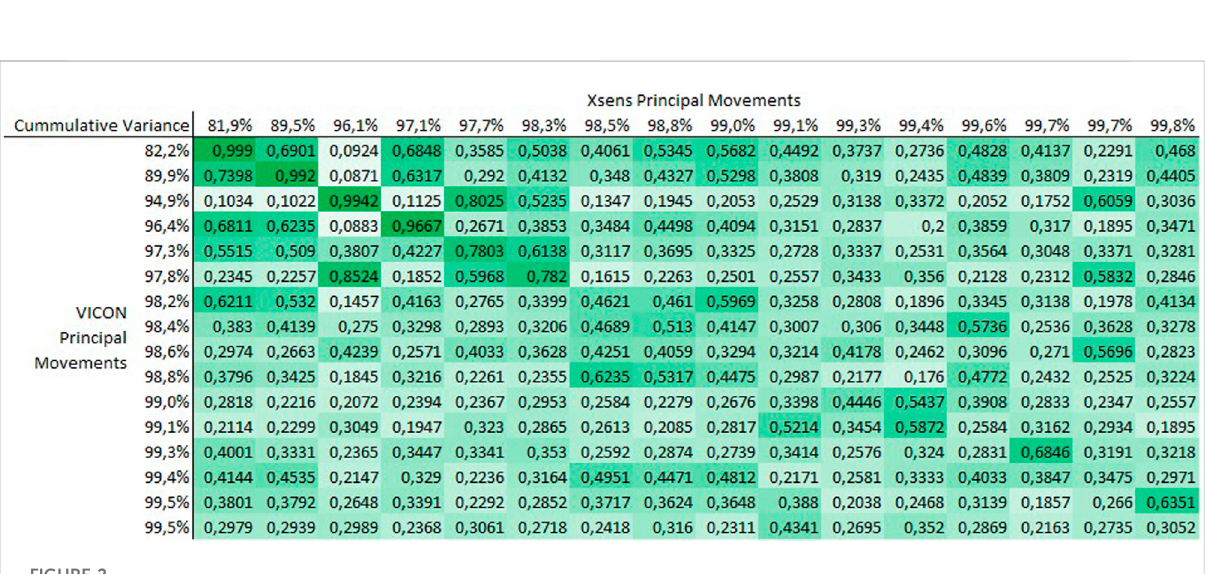
FIGURE 2 Matrix group R of the correlation coef fi cients between Vicon group PM k and Xsens group PM k . The correlation coef fi cients shown here represent the mean absolute correlation coef fi cients averaged over the subject